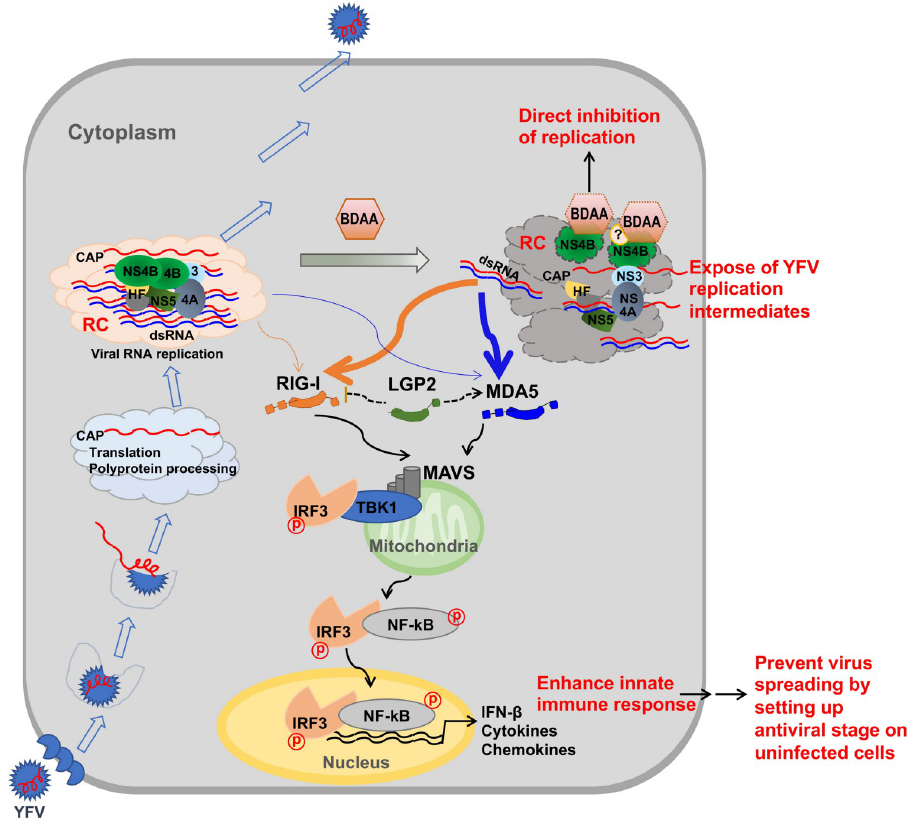
Fig 9. Illustration of the mode of BDAA action. See text for detailed